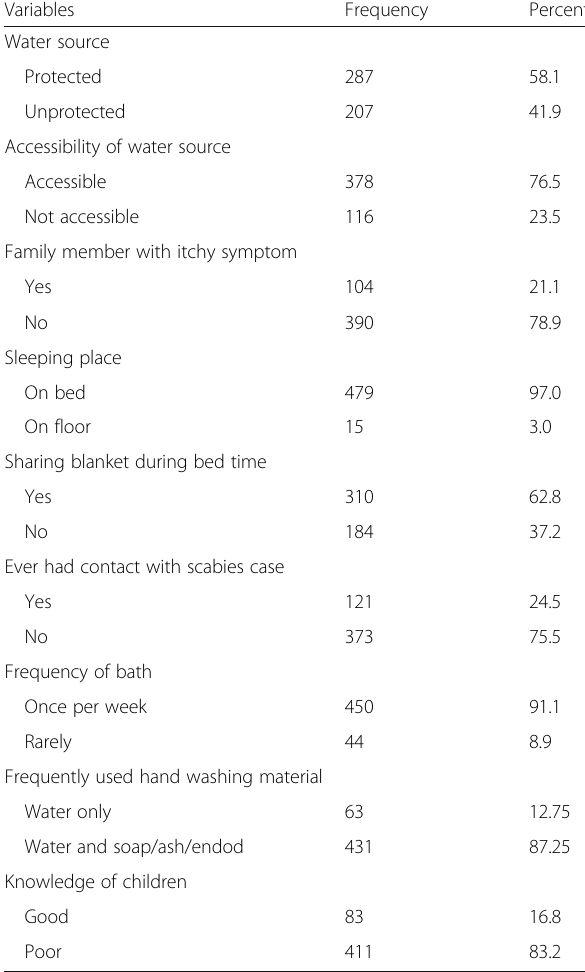
Table 2 Environmental and behavioral characteristics of students in Dabat district, northwest Ethiopia, 2018 ( n =